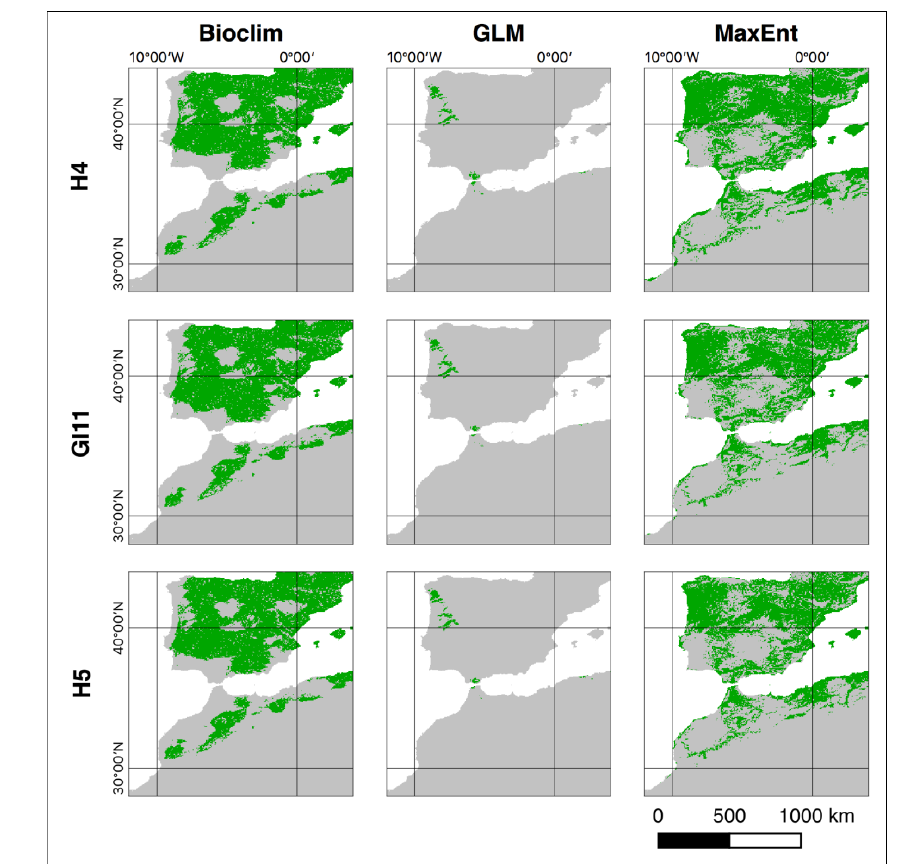
Figure 13. Exemplary result maps for the species Equus caballus for the methods Bioclim, GLM and Maxent, and the time slices H4, GI11 and H5. Green areas indicate a presence or suitable area and gray indicates a predicted absence of the species. Source: